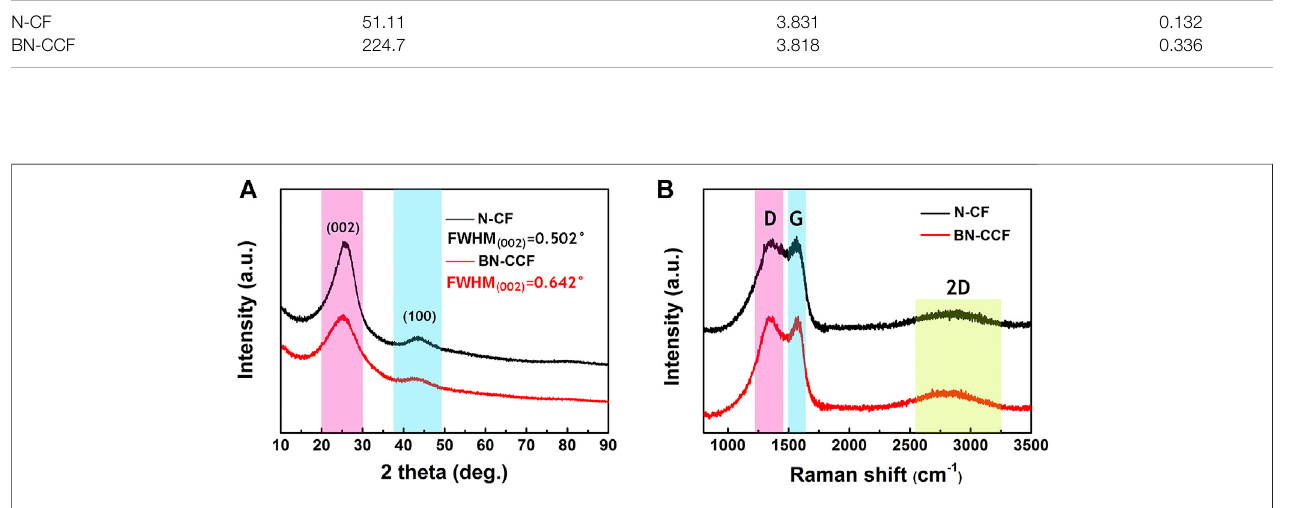
TABLE 1 | Speci fi c surface areas, mean pore diameters and pore volumes of N-CF and BN-CCF. Sample